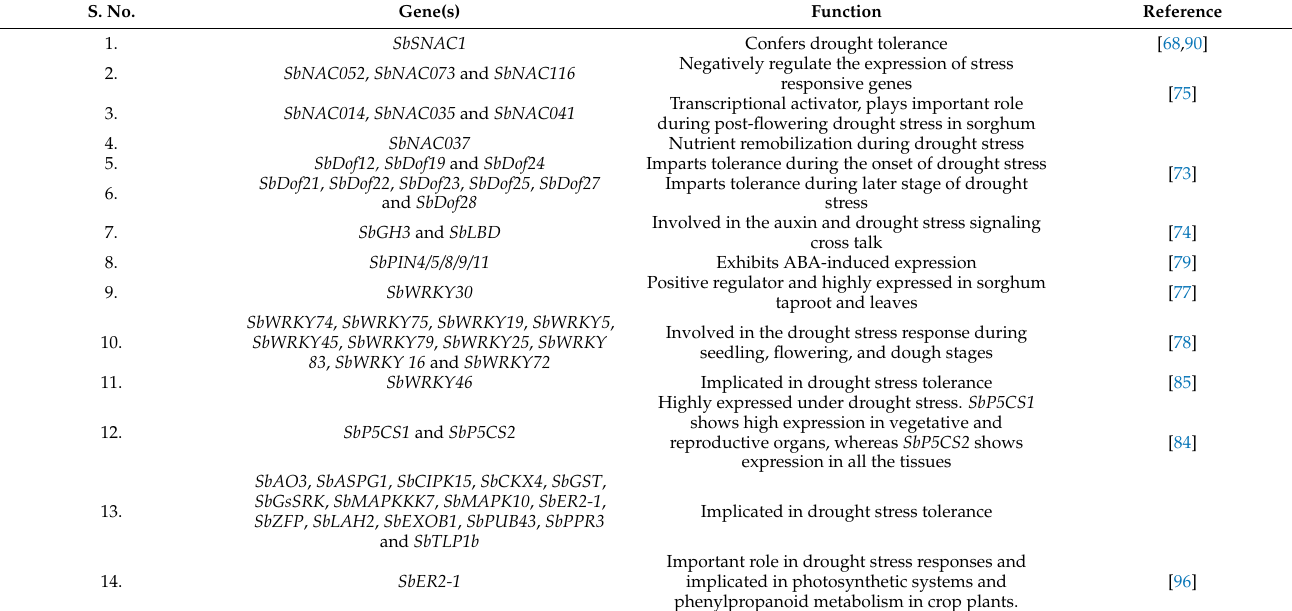
Table 1. List of genes and their function reported under drought and/or high temperature stress in sorghum. S.